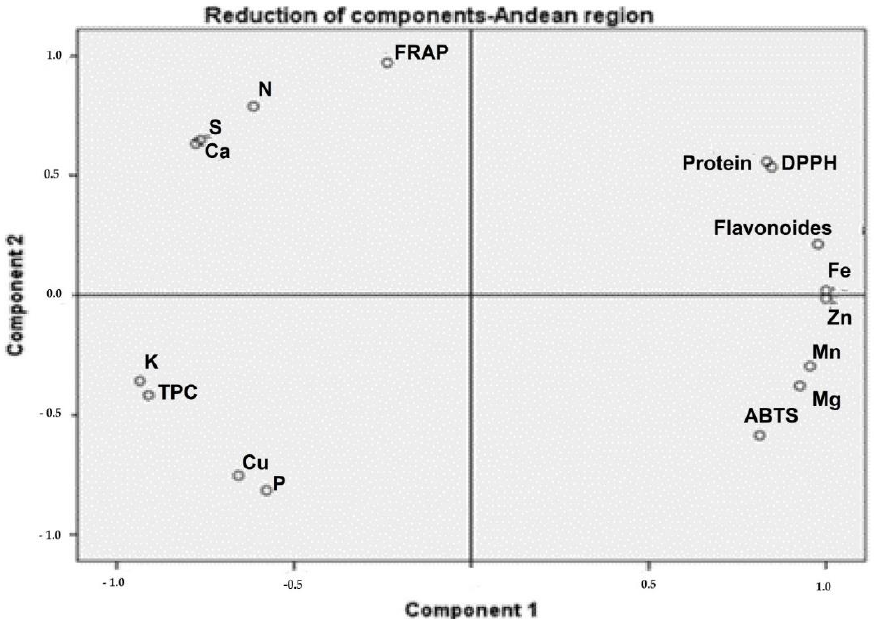
Figure 3. The phytochemical and biological composition of M. oleifera from the Andean region. Loading plot of PC1 versus PC2, showing the link between DPPH with TFC, Fe, and protein. Legend: TPC—total phenolic content, TFC—total flavonoid content, FRAP—ferric-reducing antioxidant power, ABTS—free radical scavenging activity, DPPH—free radical scavenging ability by the use of a stable DPPH • radical.